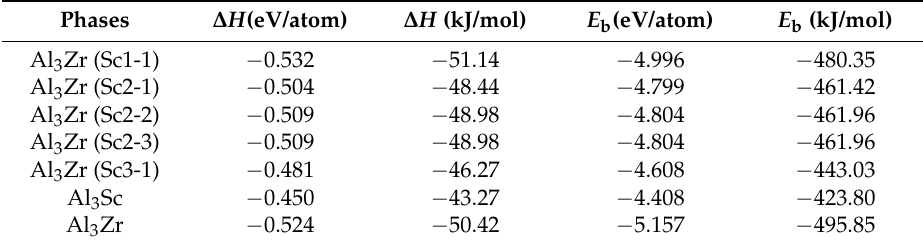
Table 5. Formation enthalpy and binding energy of Al 3 (Zr,Sc).